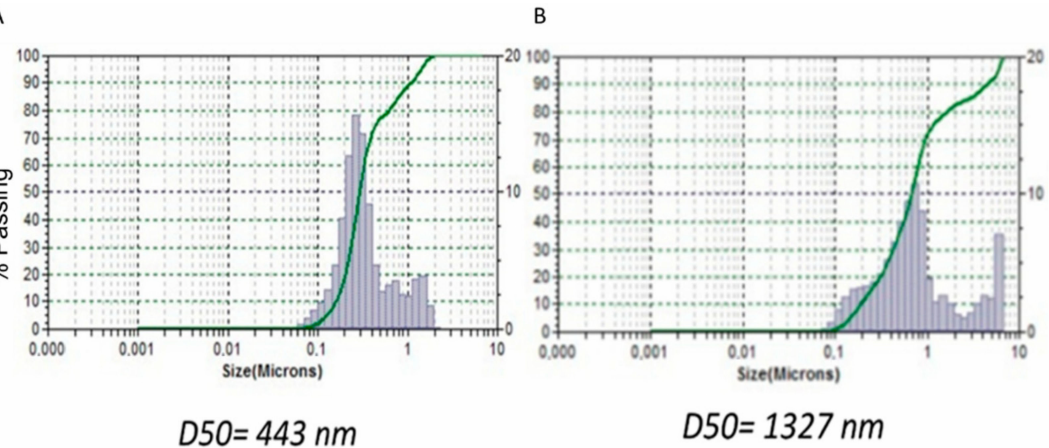
Figure 2. Validation of the QbD methodology for the optimised SNEDDS 1 ( A ) and 2 ( B ). Y -axis spans between 0–100% with labels every 10% and X -axis is a logarithmic scale spanning between